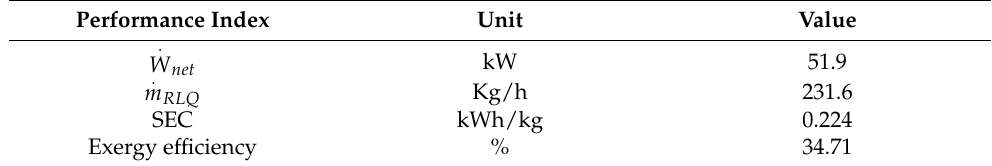
Table 11. Re-liquefaction